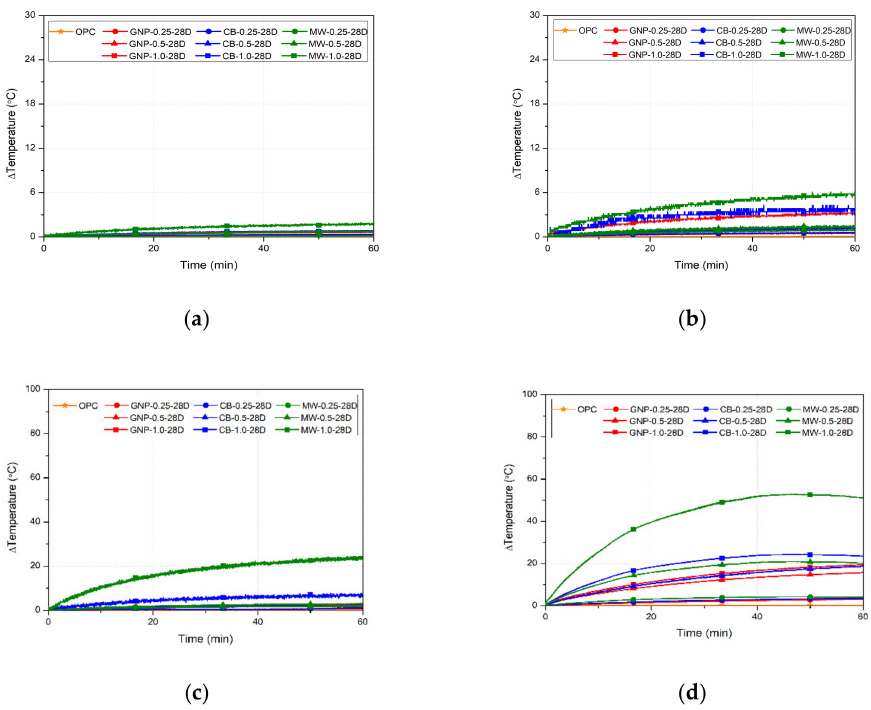
Figure 5. Temperature variation plots of the nanocementitious composites at 28 d at different voltages: ( a ) 10 V; ( b ) 20 V; ( c ) 30 V; ( d ) 60